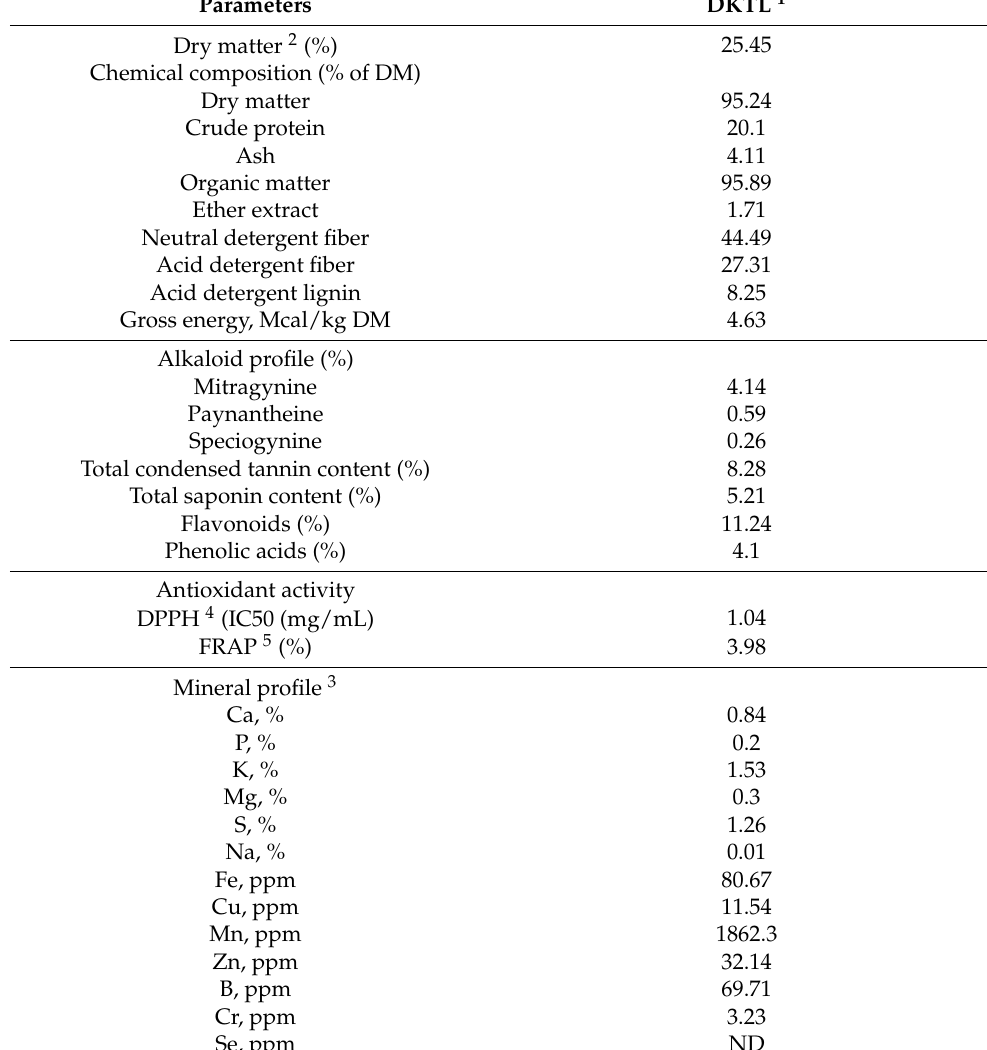
Table 2. Chemical composition and nutritive values of dried kratom leaves (DKTL) used in the experimental diets (on a dry matter basis) for